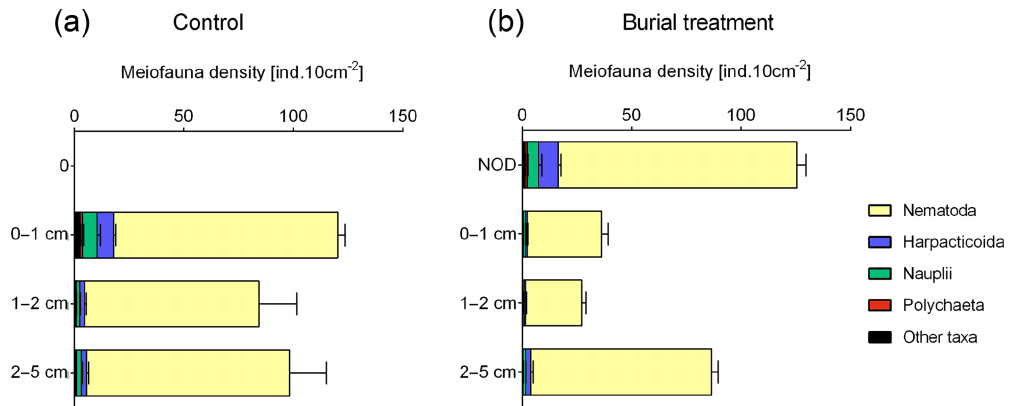
Figure 3. Vertical profile of the average meiobenthos densities (ind.10cm − 2 + standard error) in the Control and Burial treatment with a ± 2cm layer of crushed nodule particles (NOD).